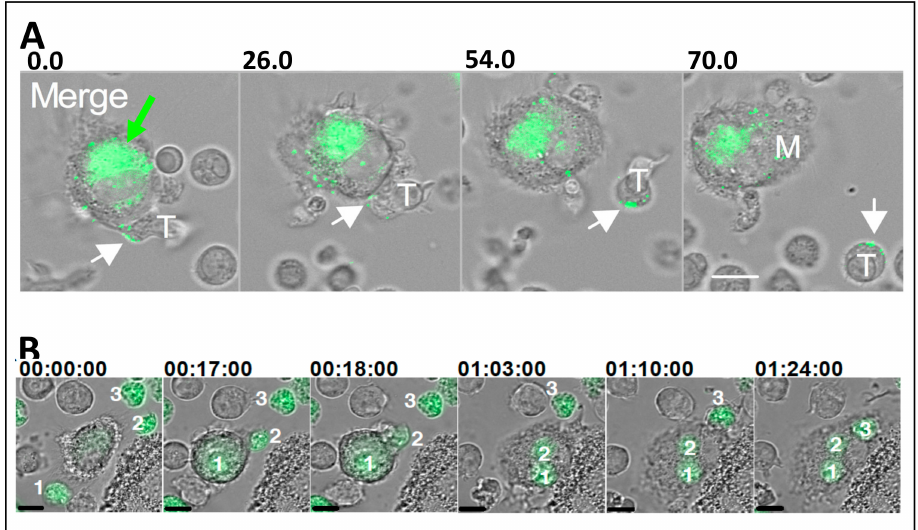
Figure 2. HIV-1 transfer between macrophages and CD4 + T cells. ( A ) HIV-1 infected macrophages transfer GFP-HIV-1 to a CD4 + T cell that is scanning the macrophage surface via transient adhesive interactions (taken from [56]). The green arrow indicates the virus-containing compartment. The white arrows show viral particles engaged with the T cell surface. Numbers above images represent minutes:seconds after initiating coculture. Scale bar = 10 µ m. ( B ) HIV-1-GFP infected CD4 + T cells being engulfed by a macrophage (taken from [65]). Numbers above images represent hours:minutes:seconds. Scale bar = 10 µ